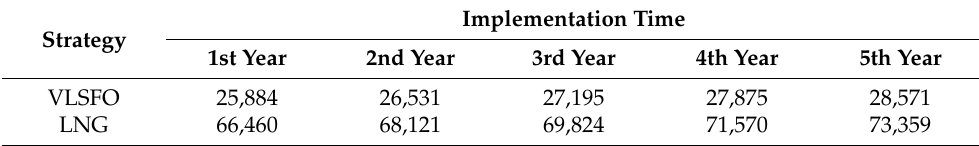
Table 16. Annual CO 2 emission reductions by the VLSFO and LNG strategies. Unit: tons.